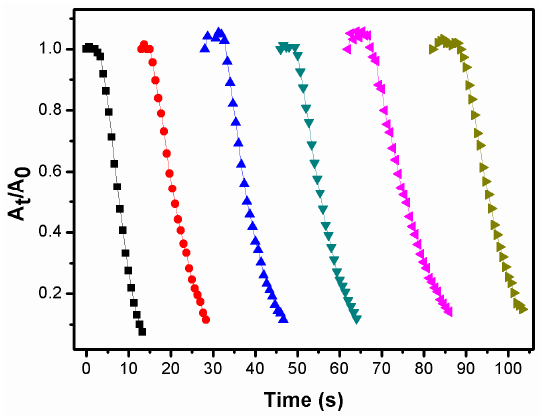
Figure 6. Recycling and reuse of AgNP@ESM for the reduction of 4-NP to 4-AP.